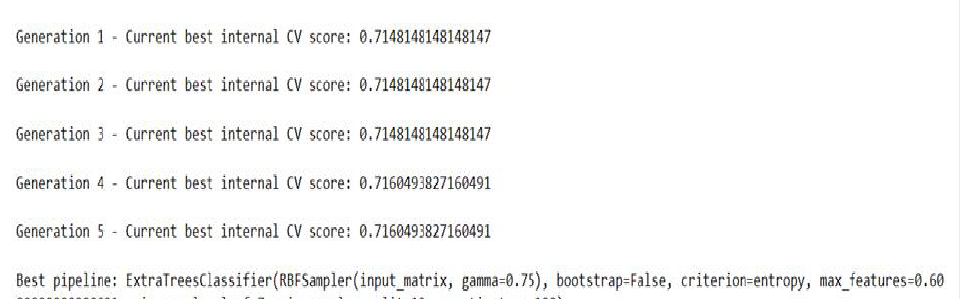
Figure 3. TPOT result